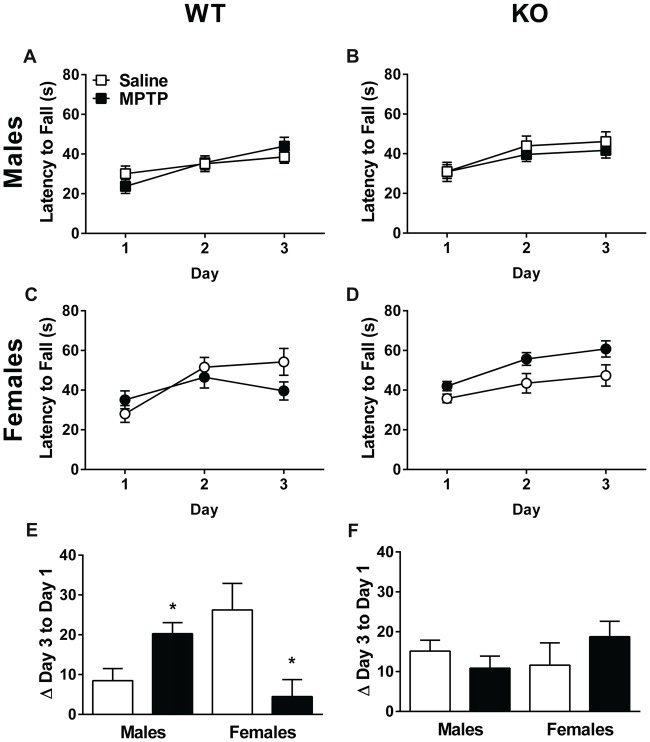
Rotarod performance of saline- and MPTP-treated WT (A,C,E) and KO (B,D,F) mice. The latency to fall is shown in (A–D) and the change from the average latency to fall on Day 1 to the average latency to fall on Day 3 in (E,F). WT (A,C) and KO (B,D) mice showed improvement on the rotarod over the 3 days of testing. WT: p < 0.001; KO: p < 0.001. Females of both genotypes performed better than males. WT: p = 0.049; KO: p = 0.018. (E,F) In WT mice, MPTP-treated males improved more than saline-treated males, while MPTP-treated females performed more poorly than saline-treated females. *p = 0.001. This effect was genotype-dependent and not seen in KO mice. The * refers to a sex × treatment interaction: WT-Change score from day 3 average to day 1 average; sex × treatment interaction: F(1,47) = 13.162, p = 0.001.